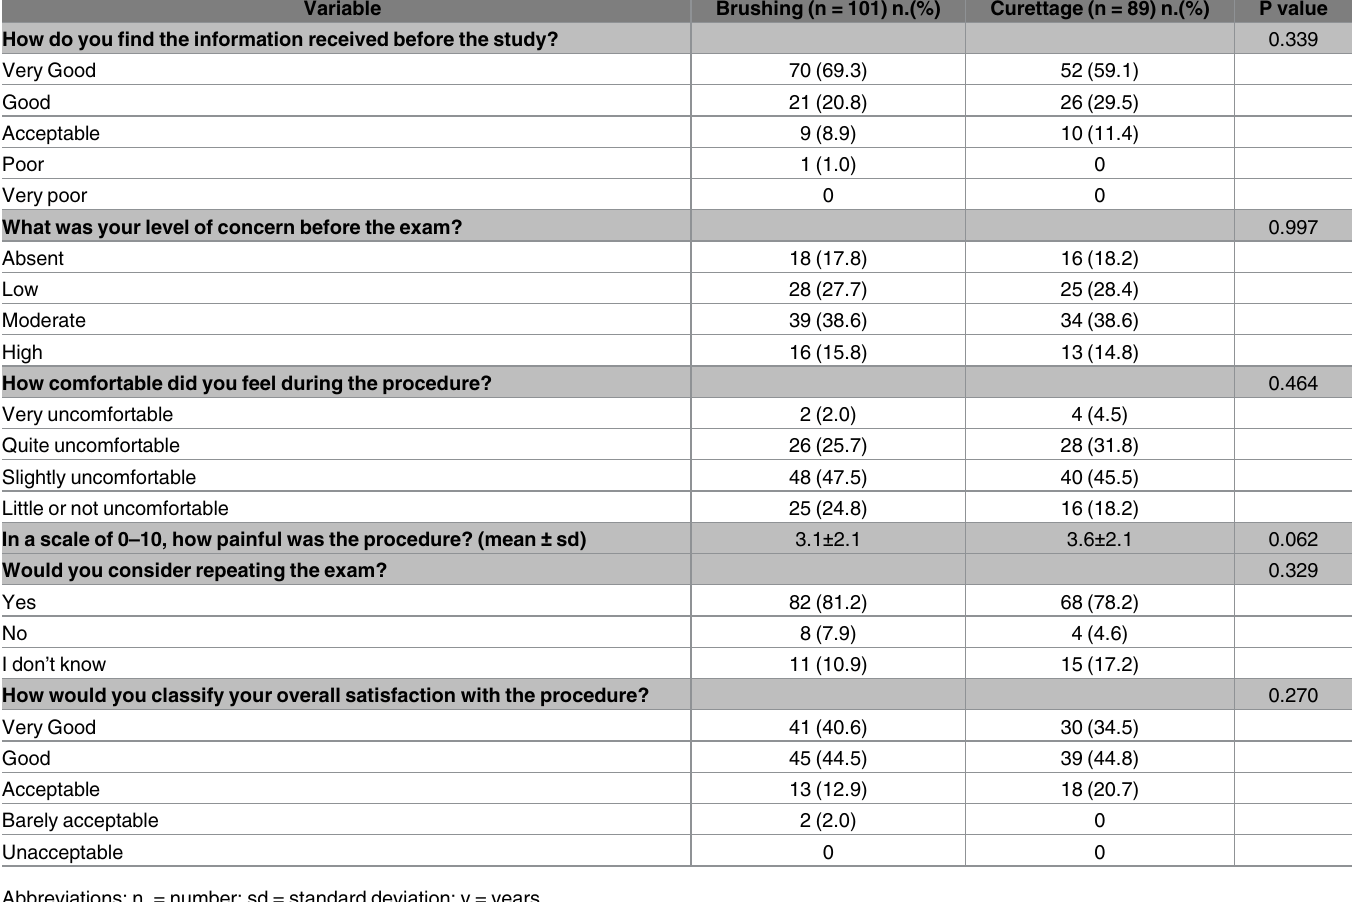
Table 3. Patient’s acceptability of the procedure by study